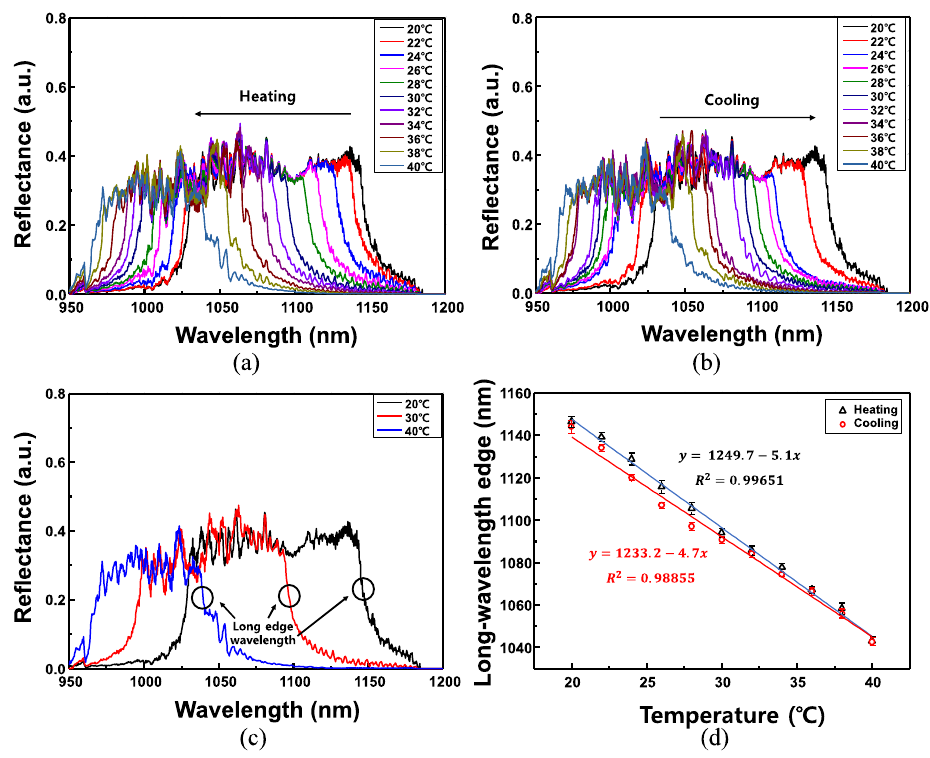
Figure 6. ( a ) Change in reflection spectra when the temperature of the CLC cell is increased from 20 to 40 °C, ( b ) change in reflection spectra when the temperature of the CLC cell is decreased from 40 to 20 °C, ( c ) reflection spectra for several temperatures, and ( d ) a graph of the variation in wavelength when the CLC cell was heated and cooled.